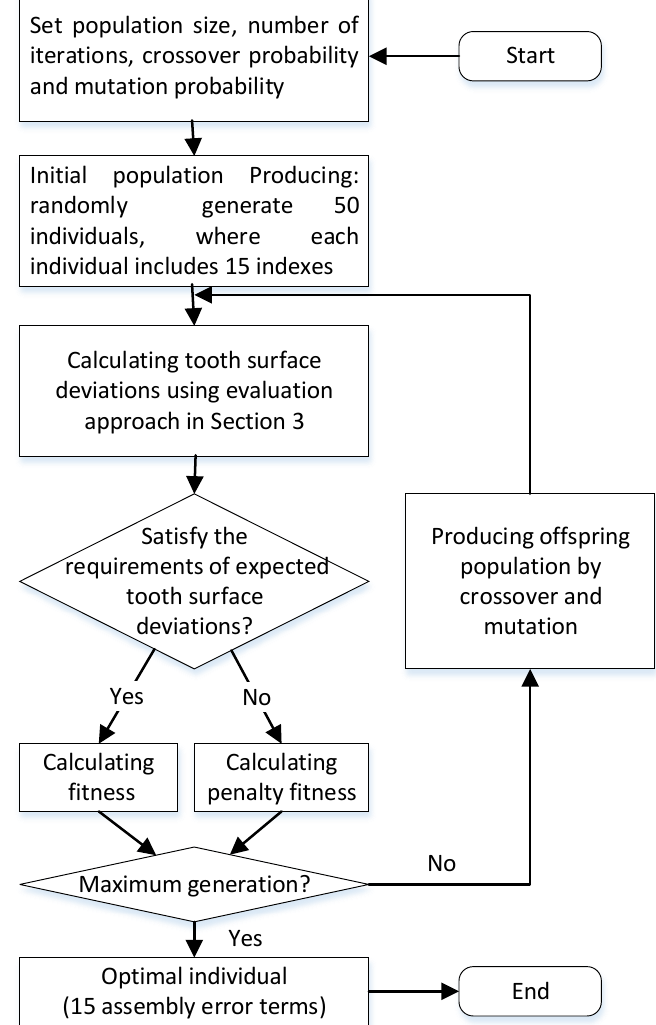
Figure 15. Flowchart for selecting assembly errors based on the GA.